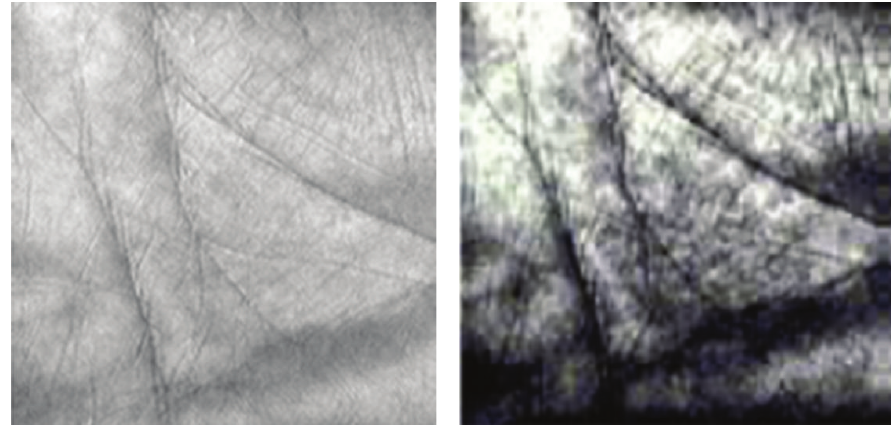
Figure 3: Segmented and normalized palmprint.